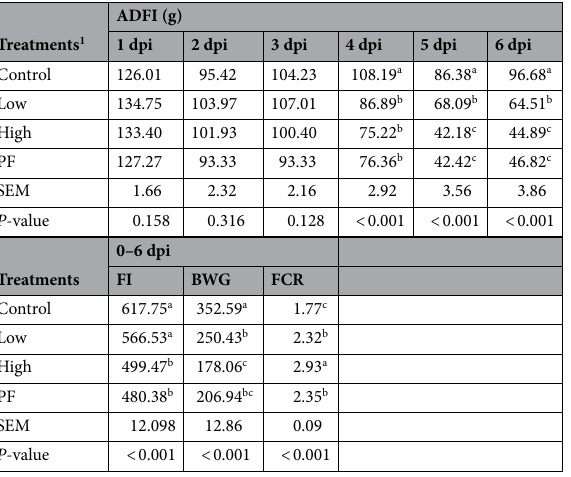
Table 1. Average daily feed intake (ADFI), cumulative feed intake (FI), body weight gain (BWG, kg) and feed conversion ratio (FCR) from 0 to 6 dpi. 1 Control: uninfected controls fed diet ad libitum and gavaged with water; Low: low Eimeria- infected group fed diet ad libitum and gavaged with 50,000 oocysts of E. maxima , 50,000 oocysts of E. tenella , and 250,000 oocysts of E. acervulina ; High: severely Eimeria -infected group fed diet ad libitum diet and gavaged with 12,500 oocysts of E. maxima ; 12,500 oocysts of E. tenella ; 62,500 oocysts of E. acervulina ; PF: an uninfected pair-fed group that fed the same amount of feed as the High group, gavaged with water. a,ab,b,c Treatments with different letters means a significantly difference between treatments by using Tukey’s HSD test, P < 0.05, N = 10.